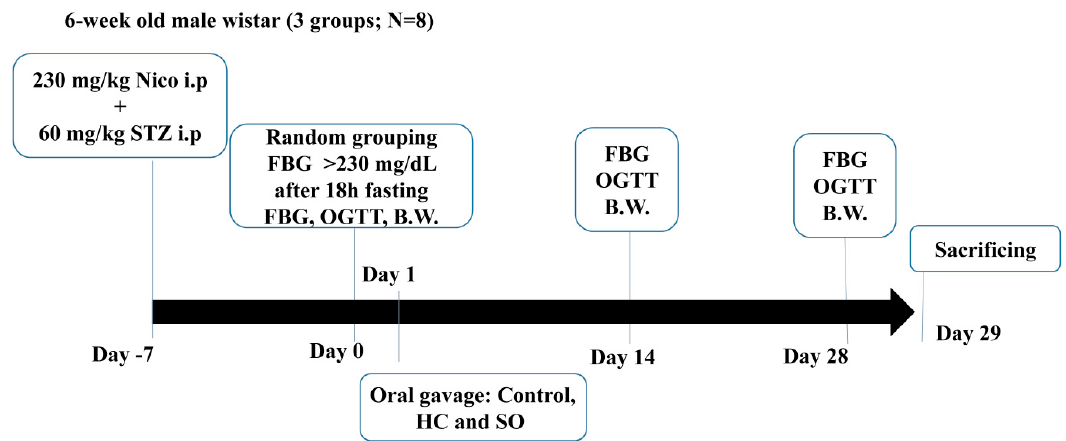
Figure 2. Study procedure for Streptozotocin (STZ)-induced type 2 diabetes rats. Diabetes was induced in 24 male Wistar rats, which were then randomly divided into three groups (Control, HC, and SO; N = 8).